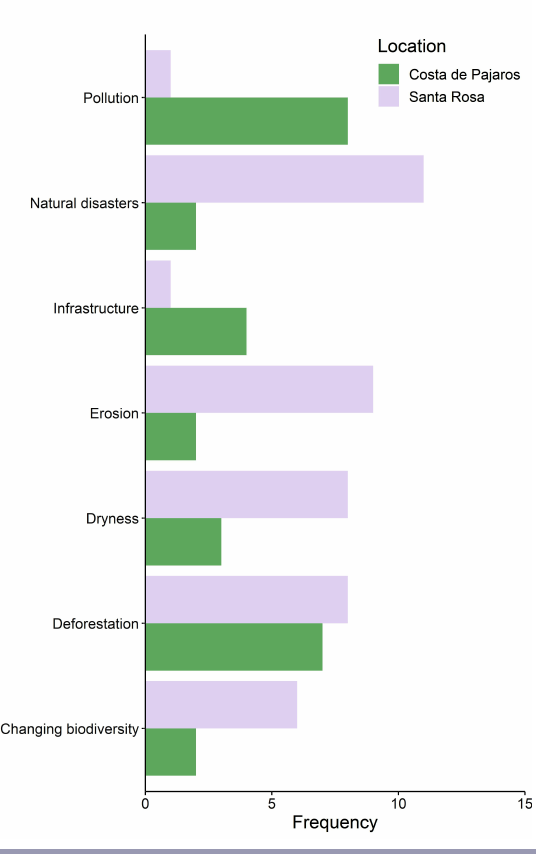
Fig. 6 . Code breakdown of responses to the question, "How has the environment changed in the last 5 years?" Frequency refers to the number of times a code was raised by different members of the community.